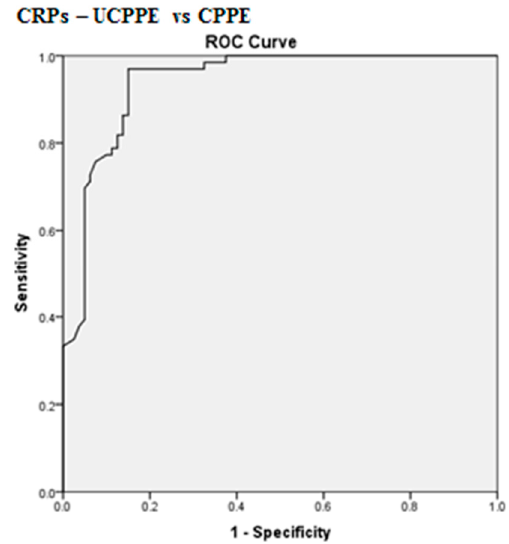
Figure 4. Receiver operating characteristics (ROC) curve of best cut-off value of CRPs for discrimination between UCPPE and CPPE. CRPs best cut-off value = 211.5 mg/L, area under the ROC curve (AUC) = 94% (95% CI: 90–97.7), sensitivity = 97%, specificity = 85.0%, total accuracy = 90.4%, positive predictive value (PPV) = 84.2%, negative predictive value (NPV) = 97.1%, odds ratio = 181.3 (risk for CPPE when CRPs value > 211.5 mg/L), p < 0.0001.